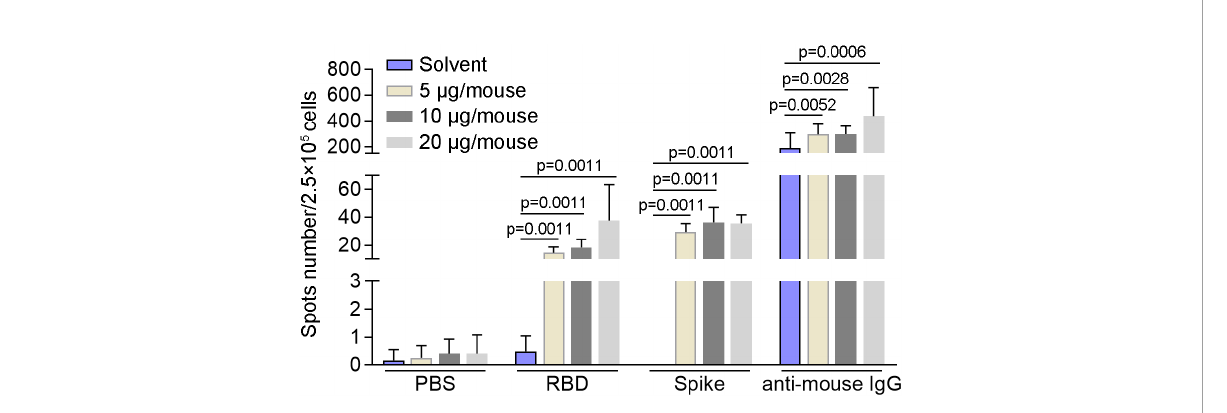
FIGURE 4 The speci fi c activity of B cells induced by SYS6006 in mice. 6-8-week-old female BALB/c mice were immunized intramuscularly twice with the indicated doses of SYS6006 with a 21-day interval. The splenocytes were collected 7 days after the 2 nd vaccination, stimulated with RBD and spike antigens, and tested for B cell activity via mouse IgG ELISpot assay (n=6). Data are presented as mean ± SD. RBD, receptor-binding domain.